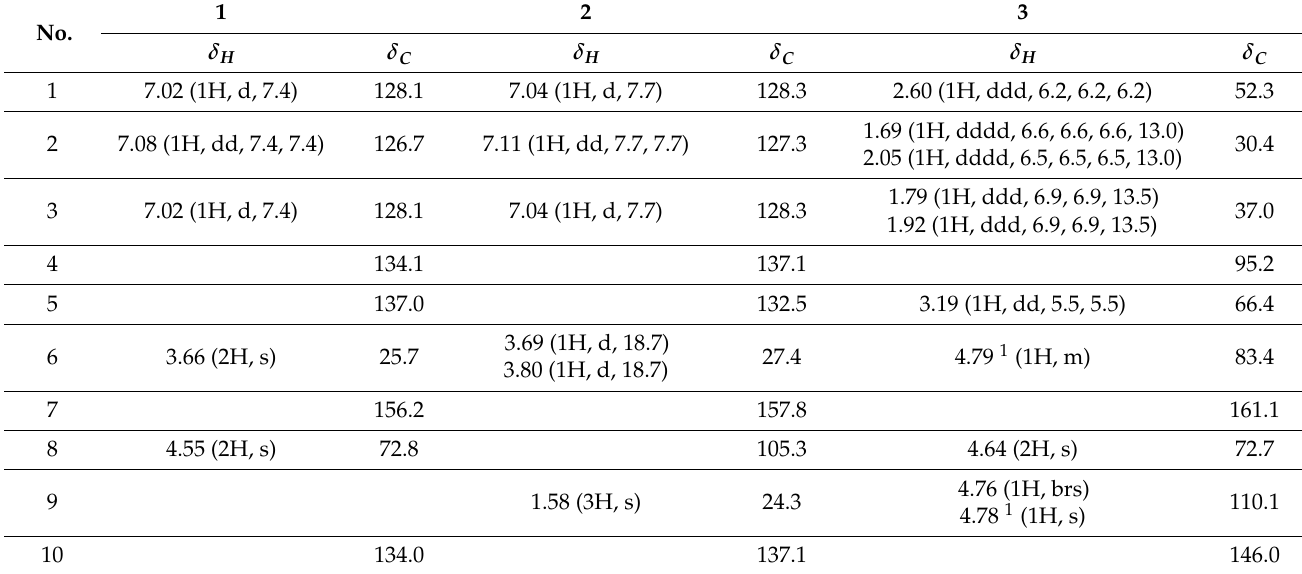
Figure 1. Chemical structures of the isolated sesquiterpenes ( 1–16 ) and the reference substances furanoeudesma-1,3-diene (FUR) and curzerenone (CUR). Table 1. 1 H and 13 C-NMR data (600 and 150 MHz, respectively; CDCl 3 , δ in ppm, J in Hz) for compounds 1–3 (s singlet, d doublet, br broad, m multiplet).